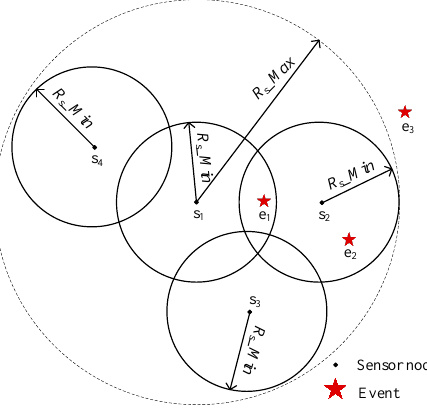
Figure 2. Sectional view of the relationship between nodes and events.